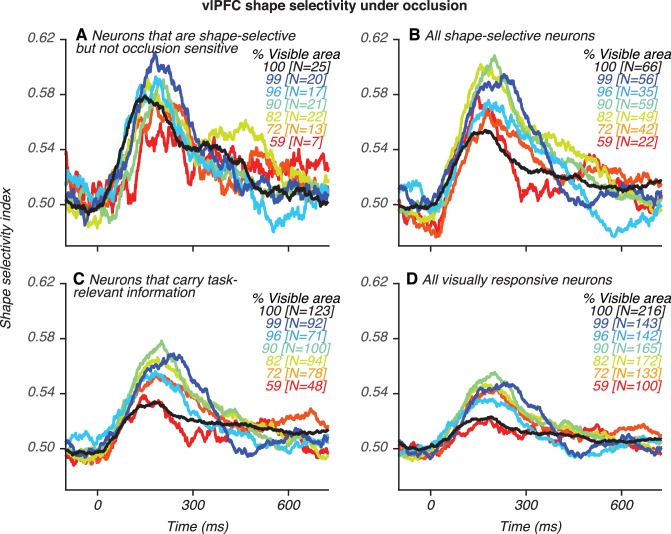
Shape selectivity as a function of occlusion for different groups of vlPFC neurons.(A) Neurons that are shape-selective but not occlusion-sensitive. (B) All shape-selective neurons. (C) All shape-selective and occlusion-sensitive neurons, that is neurons that carry any task-relevant information. (D) All visually-responsive neurons. Shape and occlusion sensitivity was assessed with a 2-way ANOVA (see Materials and methods for details). Shape selectivity was stronger for shape-selective than occlusion-sensitive neurons (compare panels A–B with Figure 3D) but across all neuronal groups, including neurons not significantly influenced by occlusion (in A), shape selectivity was strongest at intermediate occlusion levels.